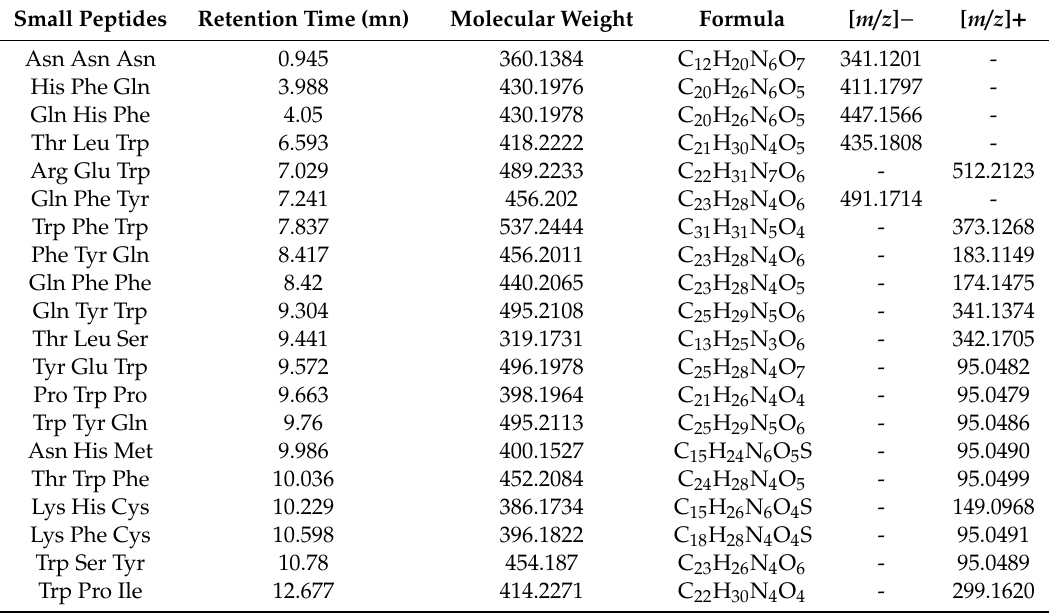
Table 1. Peptide-like proteins identified by the HR-LCMS technique in T. polium methanolic extract. Small